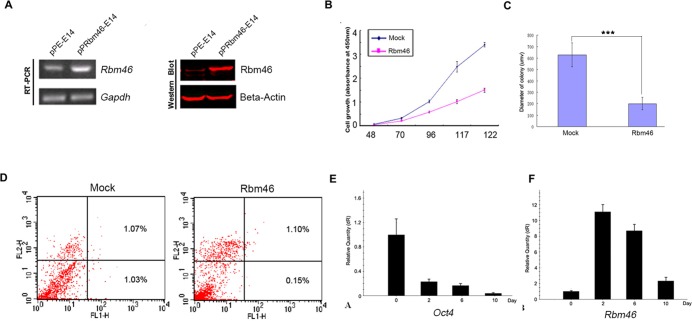
Rbm46 inhibits mESC proliferation.(A) RT-PCR and Western Blot analysis of the pPy-Rbm46-E14 stable cell lines. (B) CCK-8 analysis of the proliferation rate of pPE-E14 cells and pPy-Rbm46 cells within 72 hours after seeding. Experiment was performed in triplicate. Error bars showed the standard deviation. (C) Statistics analysis of the average diameter of the colonies formed by pP-E14 cells and pPy-Rbm46 cells, respectively. Experiment was performed in triplicate. Error bars showed the standard deviation. ***, p<0.001; t-test. (D) Representative profiles of the pPE-E14 cells and pPy-Rbm46 cells by Annexin V/PI staining. (E) and (F) RT-PCR analysis of Oct4 and Rbm46 mRNA level at the indicated time points in E14 cells induced to undergo differentiation by removal of LIF. Experiments were performed in triplicate. Error bars showed the standard deviation.